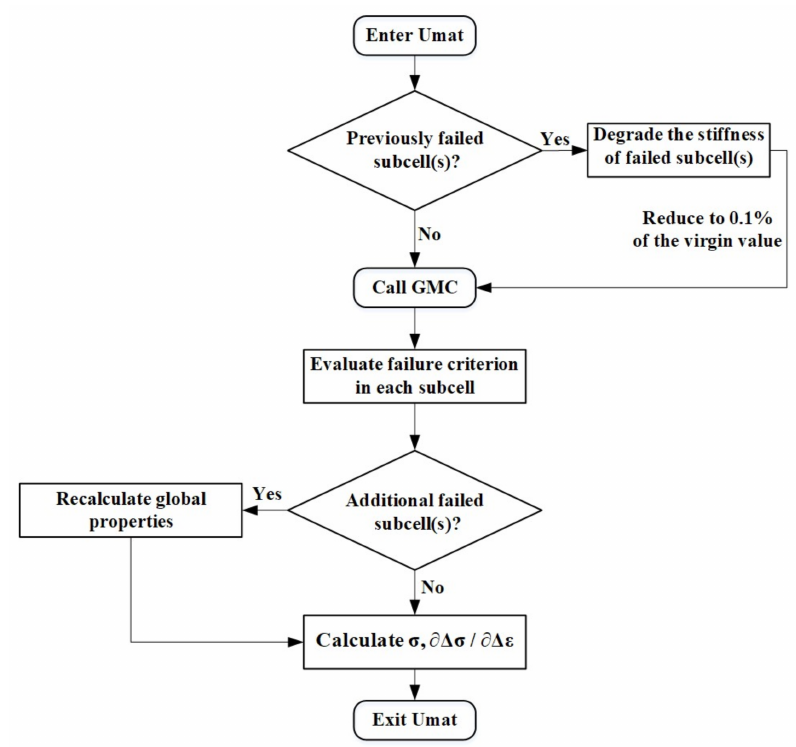
Figure 4. Flow chart of multiscale failure analysis using